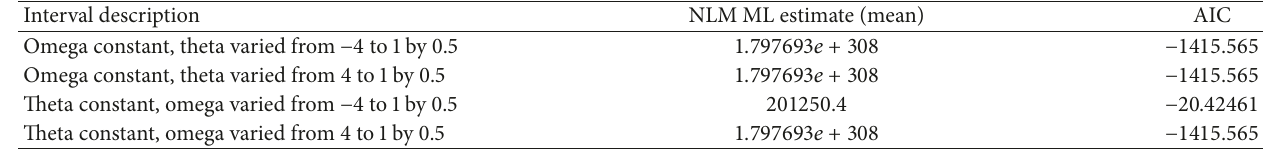
Table 14: Summary of results for lambda = 0.5, 𝑛 = 10 𝑖 , 𝑖 = 6 .